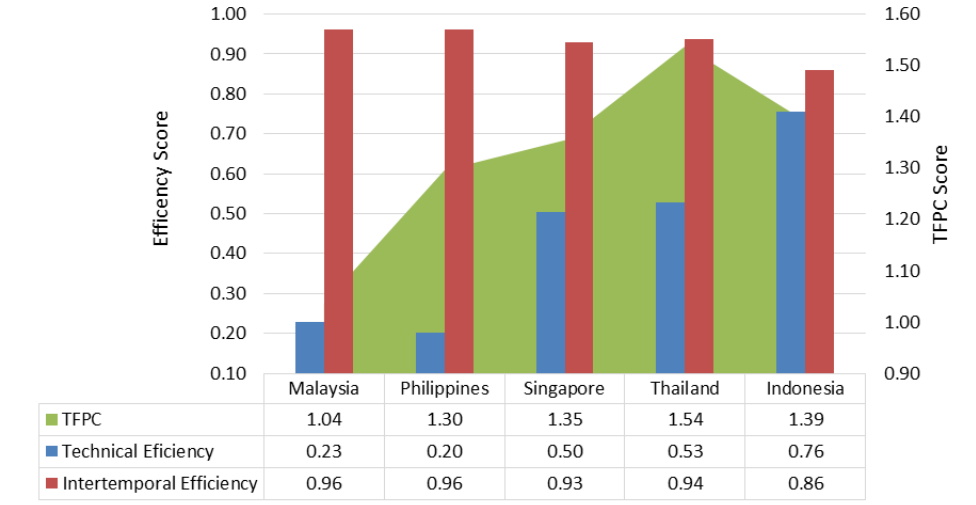
Figure 3. TFPC, Technical Efficiency, and Intertemporal Efficiency of Telecommunication Firms Catagorized by Country in ASEAN-5 Source: Data